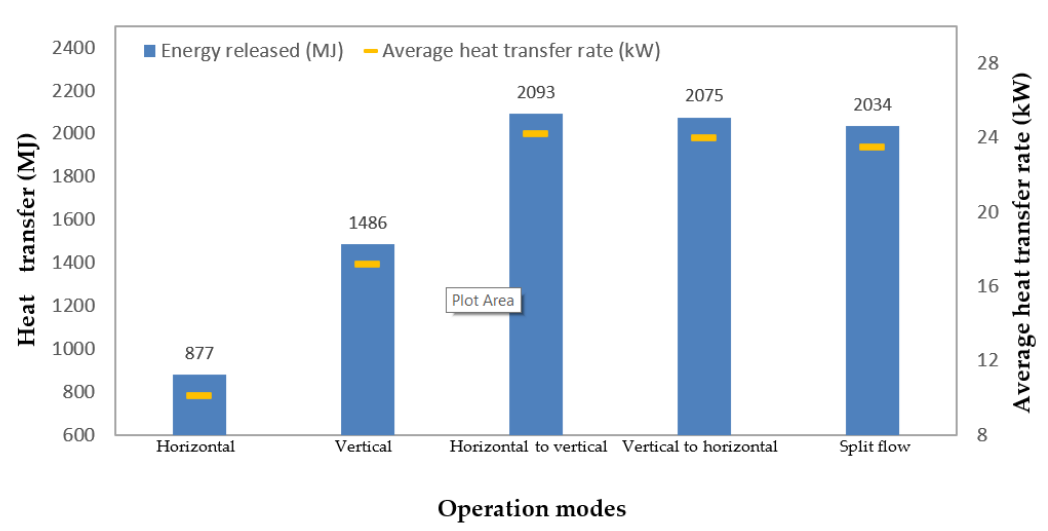
Figure 10. Energy released in 3 days and average heat transfer rate of the GHE under intermittent operation in Adelaide (where the inlet fluid temperature = 50 ◦ C, fluid mass flow rate = 0.6 kg / s, length of horizontal GHE = 200 m, and length of vertical GHE = 200 m).